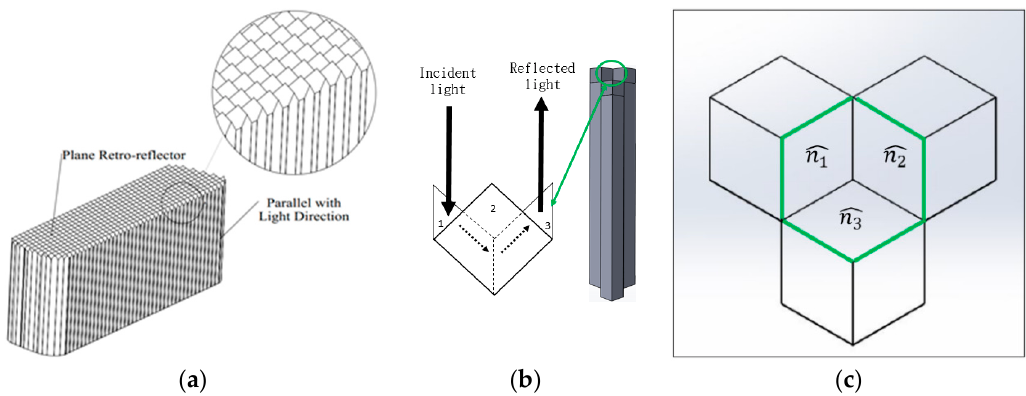
Figure 2. ( a ) Corner-cube retroreflector composed of groups of pins; ( b ) a group of pins; ( c ) reflecting surfaces of pin group (green lines show inner region).